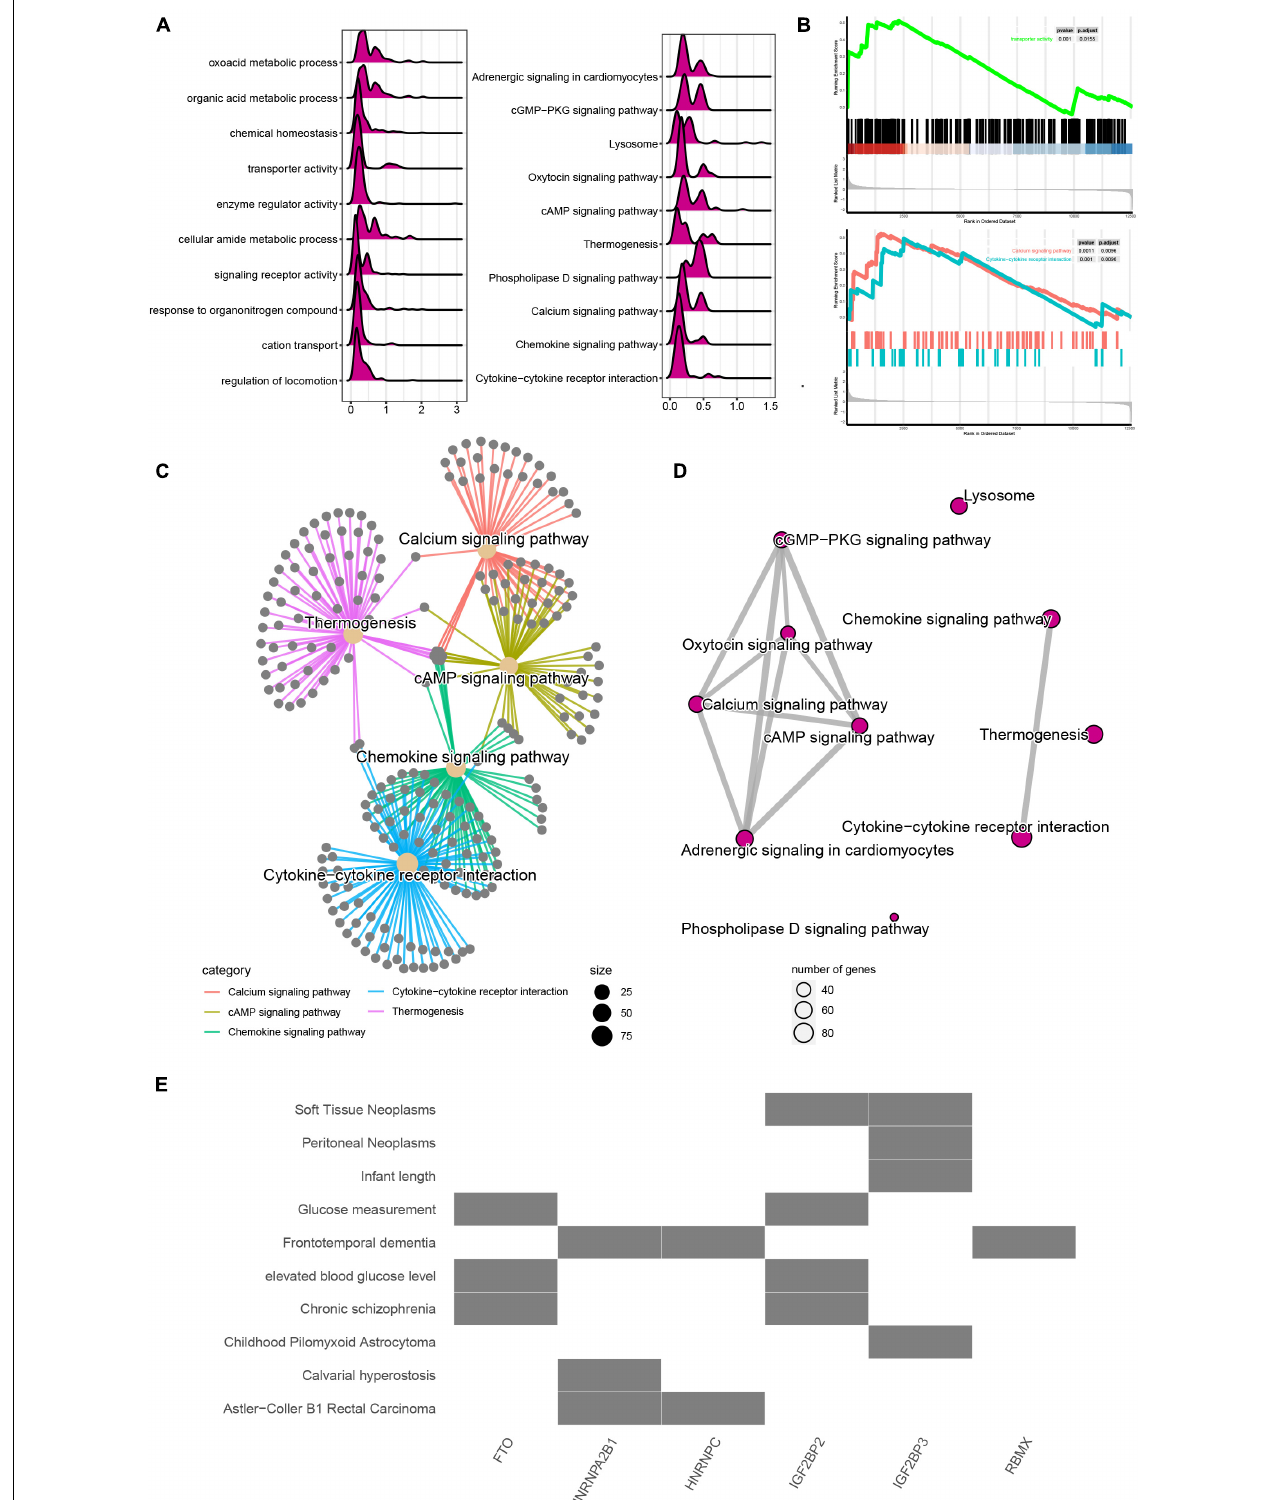
FIGURE 2 | Functional annotation of m6A regulators in MI. (A) Mountain map presented functional annotation of DEGs in MI. (B) Gene Set Enrichment Analysis demonstrated that DEGs in MI were related to transport activity and calcium signaling. (C) Top 5 enriched signaling have strong crosstalk. (D) Calcium signaling and chemokine signaling play a key role in MI. (E) Functional annotation of m6A regulators in MI.